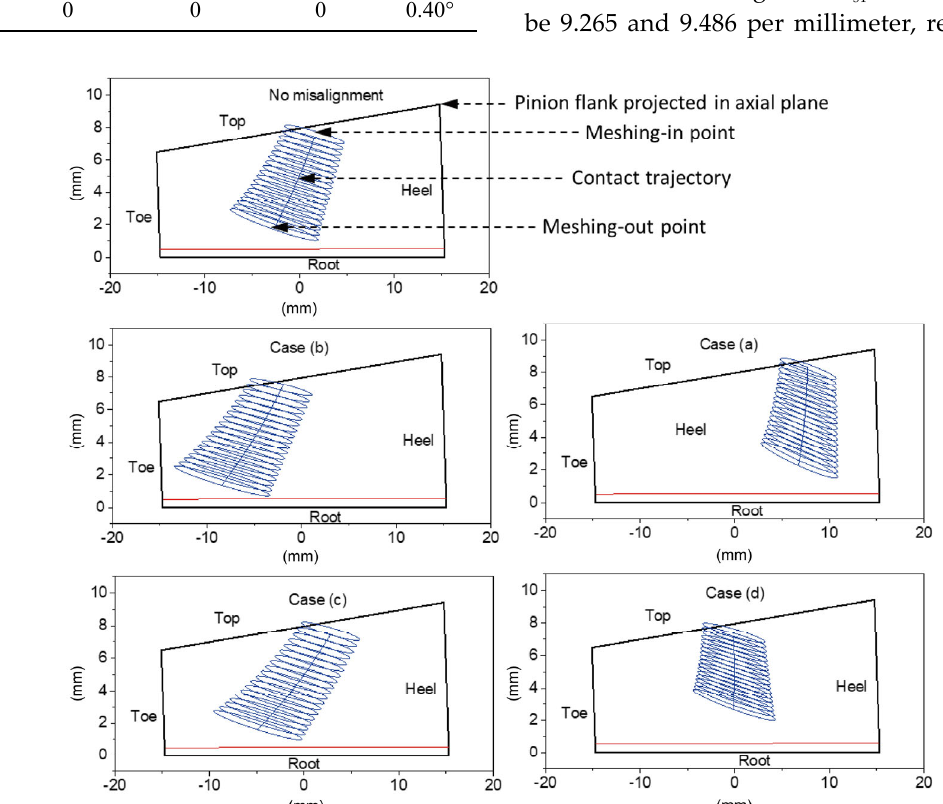
Fig. 6 Contact trajectories under different error